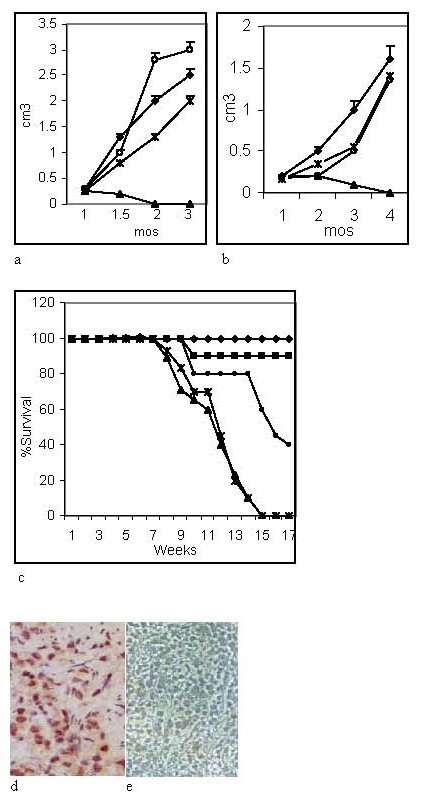
a Mice were injected in the scrotal sac with 1 × 106 PC-3ML cells. Treatment was initiated at day 28, and mice treated with (▲) 4 ug/biw DNAZYM-1P) (n = 50); (◆) scrambled oligonucleotide (n = 30); (Ж) vehicle (n = 20) or (○) untreated. The agent was injected in the scotal sac in 0.1 ml buffer. Tumor size was measured with calipers at 2 week intervals. 5b. Mice (n = 30/agent) were injected i.v. via the tail vein at day 1 and day 10 with 1 × 105 cells/ml (in 0.1 ml) then treatment started after 2 weeks by i.v. injection via the tail vein weekly of (◆) scrambled oligonucleotide, (○) vehicle, (Ж) buffer, and (▲) DNAZYM-1P. Tumor volume was measured in 2 mice at 2 weeks by sacrificing a few mice for measurements and then at the time of sacrifice following treatment of mice for 1, 2, 3 and 4 mos. 5c. Mice were injected with tumor cells according to methods in fig. 5b and treated with either (◆) 4 ug/ml, (■) 3 ug/ml and (●) 2 ug/ml biw DNAZYM-1P. Control mice were treated with (▲) lipofectamine and (Ж) scrambled oligonucleotide. Mice were treated for 2 mos, then treatment was discontinued for up to 17 weeks. 5d–5e. H&E and RPS2 antibody immunolabeled sections of a tumor from a mouse treated with the scrambled oligonucleotide for 2 mos (see fig. 5c).